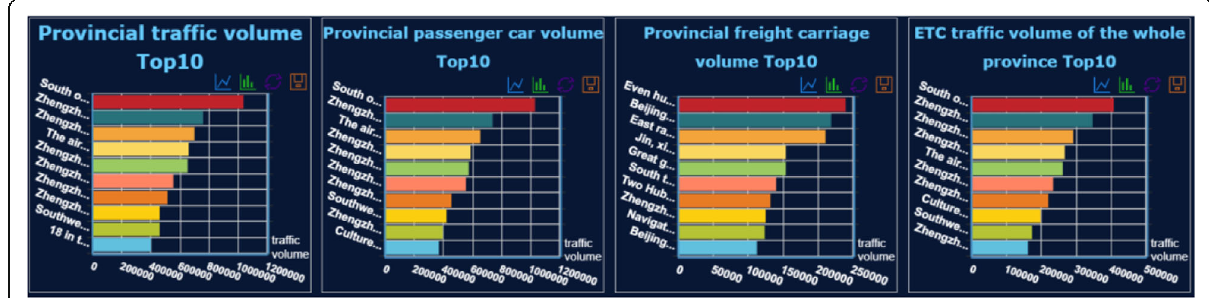
Fig. 6 Potential hotspots in multiple